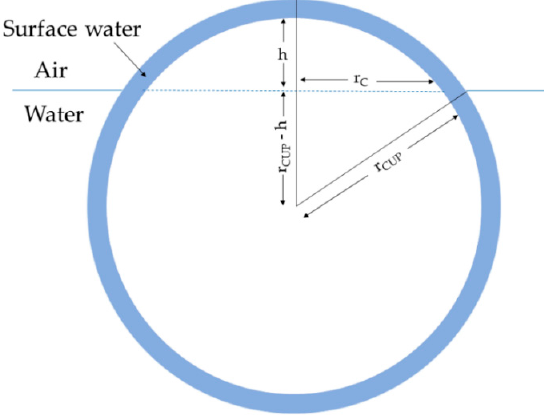
Figure 6. Deformation of the surface by CUP particles at the N 2 –water interface.